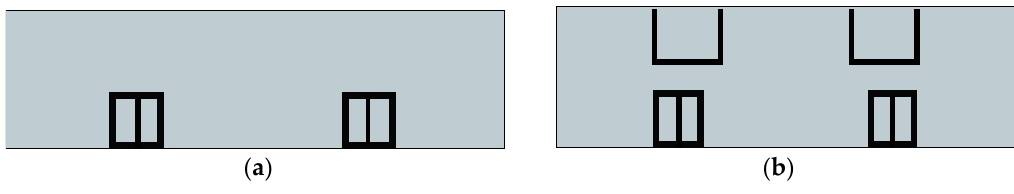
Figure 3. LLRS layouts for numerical models: ( a ) cores as in original building for designs D-2–D-5; ( b ) cores and additional C-shaped walls for design D-6–D-7.